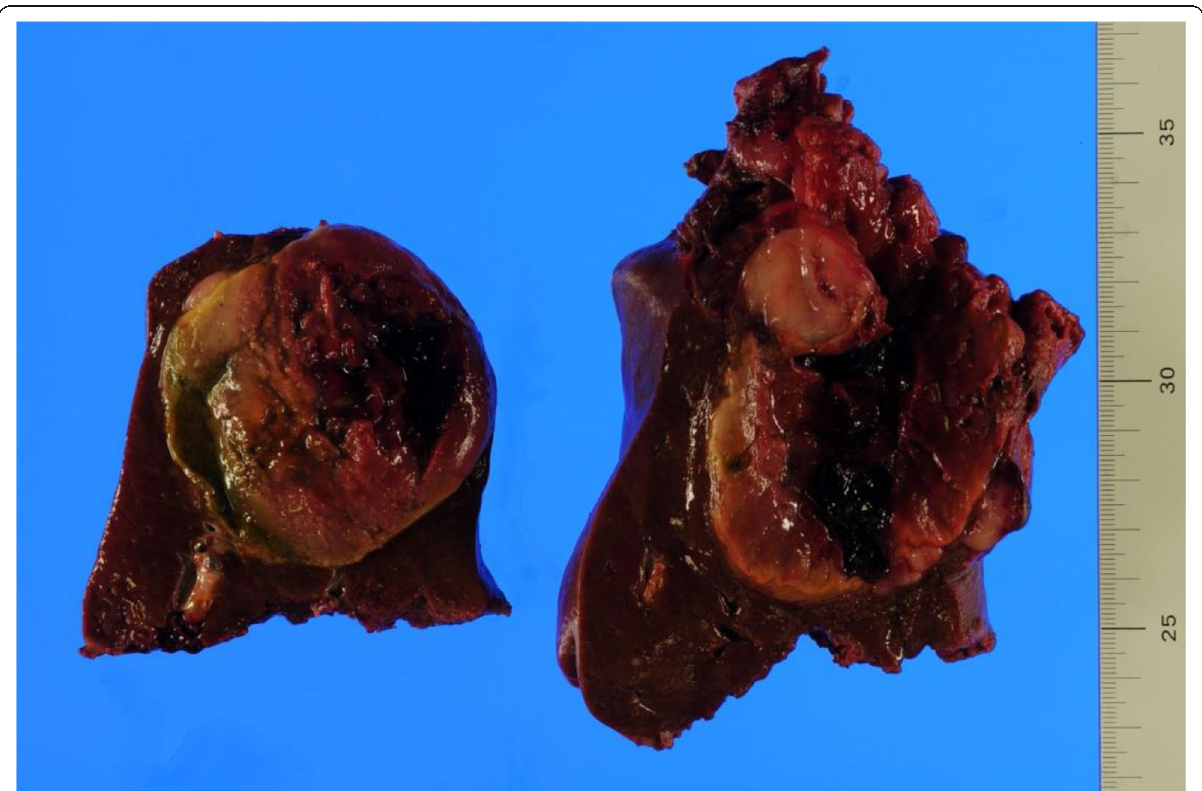
Fig. 3 Specimen of the resected posterior segment (S6/7) including a tumor in S5 of the liver. The majority of ruptured tumor was